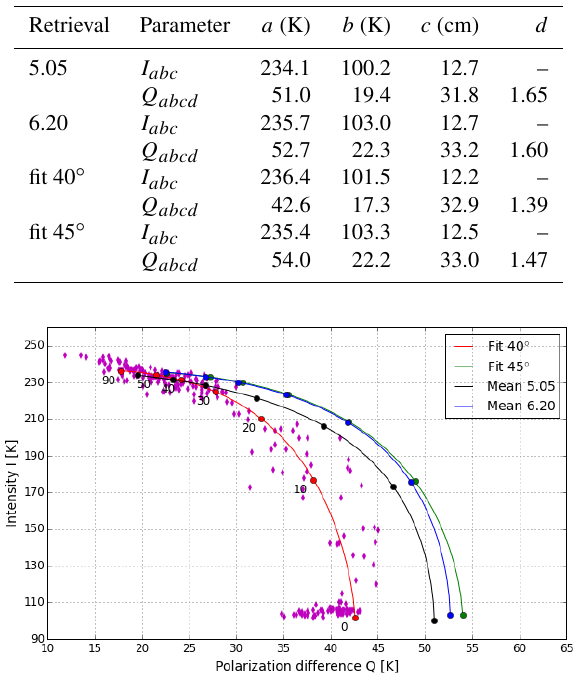
Figure 1. Sea ice thickness retrieval curves derived from SMOS data representing the original algorithm (black), the new data ver- sion (blue) and 45 ◦ (green) and 40 ◦ (red) incidence-angle-fitted TBs. Dots represent data from the three training areas used for ob- taining the 40 ◦ fit curve. Numbers under the curve represent the SIT in